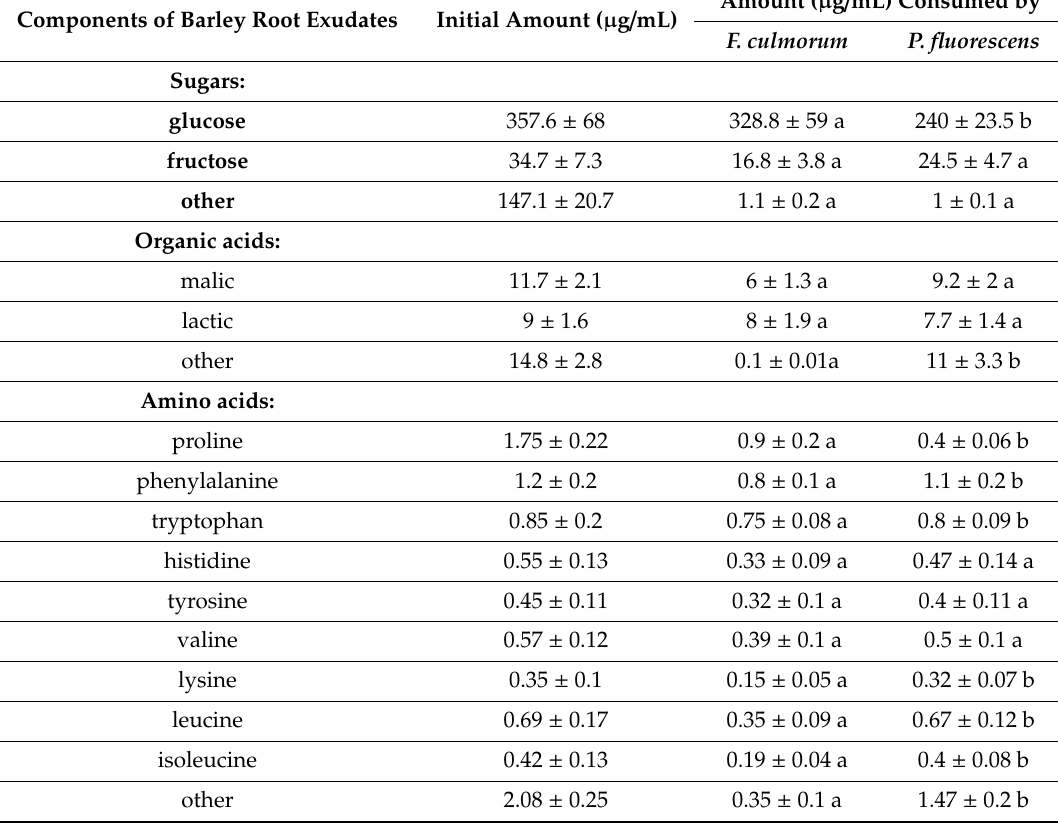
Table 2. Components of barley root exudates consumed by Fusarium culmorum and Pseudomonas fluorescens during 5 days of growth in the exudate solution. (Based on the results of earlier studies [29]). Components of Barley Root Exudates Initial Amount ( µ g / mL)